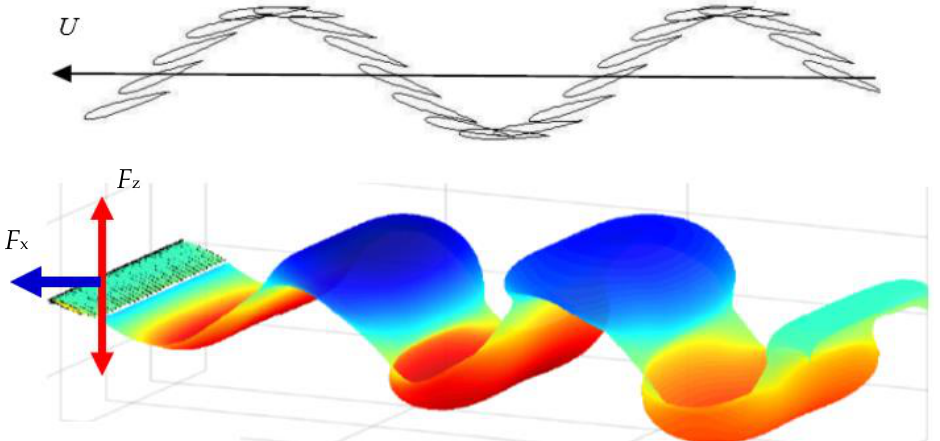
Figure 1. Flapping thruster: consecutive positions of foil oscillatory motion and trailing vortex wake associated with the formation of a reverse Karman vortex street leading to the generation of oscillatory vertical lift force and horizontal thrust force (red arrows) with a significant non-zero mean (blue arrow).